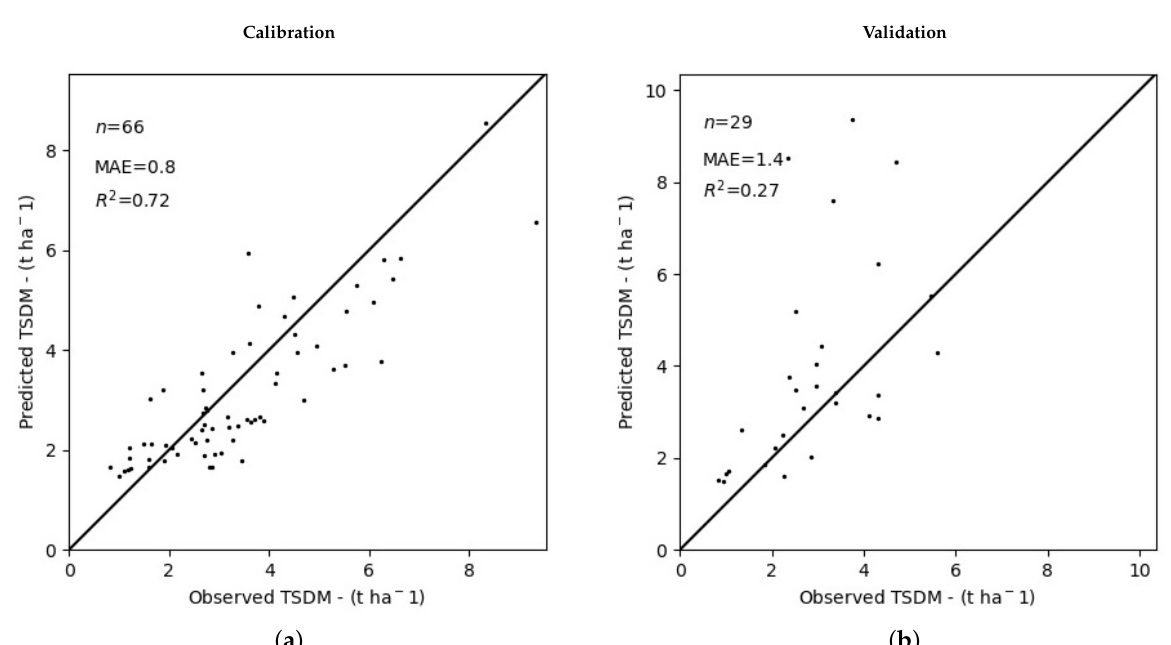
Figure 6. Least squares linear relationship between field measured biomass and RPAS predicted biomass for both the model training ( a ) and testing ( b ).